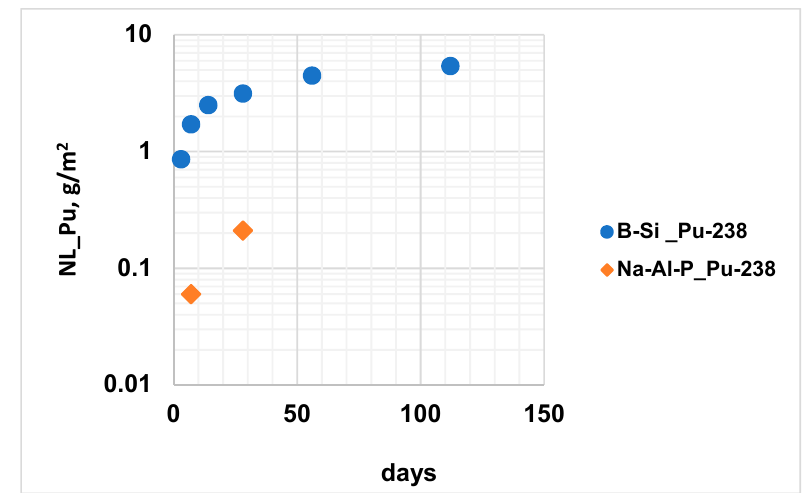
Figure 4. Plutonium normalized mass losses (NL_Pu) from samples of 238 Pu ‐ doped borosilicate and alkali ‐ aluminophosphate glass in distilled water at a temperature of 90 °C. Expanded uncertainty for all data is less than 20% of the value.